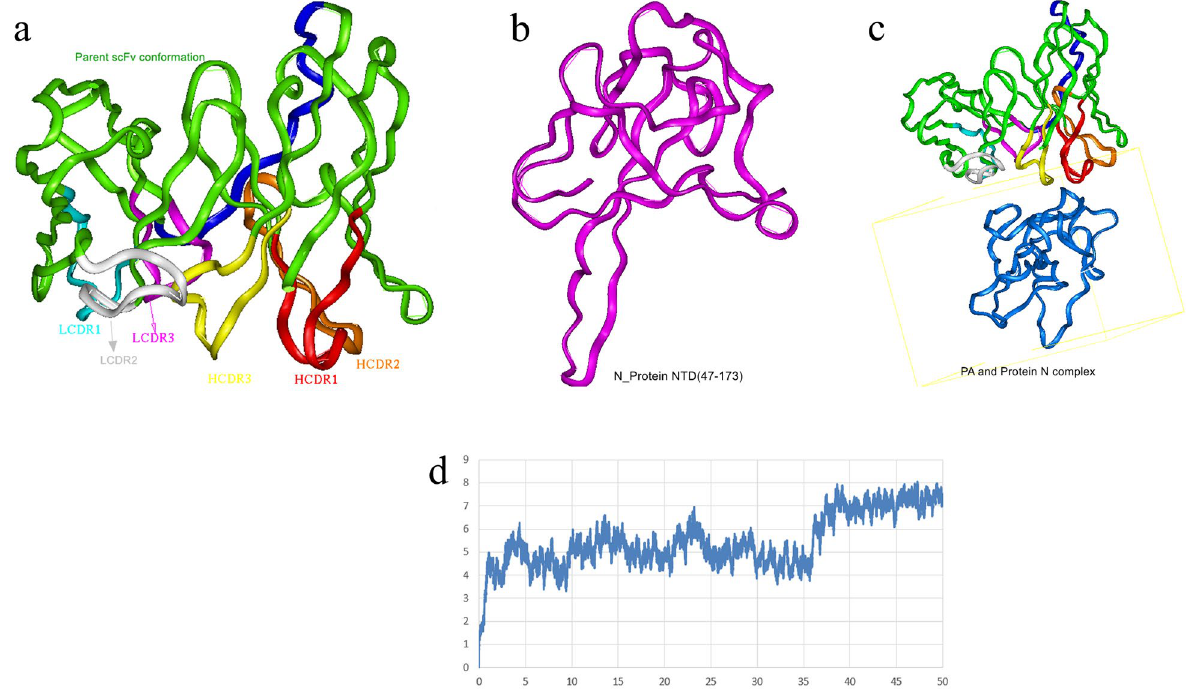
The green ribbon denotes the orientation of the 2G4 scFv fragment, the red ribbon denotes HCDR1, the orange denotes HCDR2, the yellow denotes HCDR3, the light blue denotes LCDR1, the white denotes LCDR2,